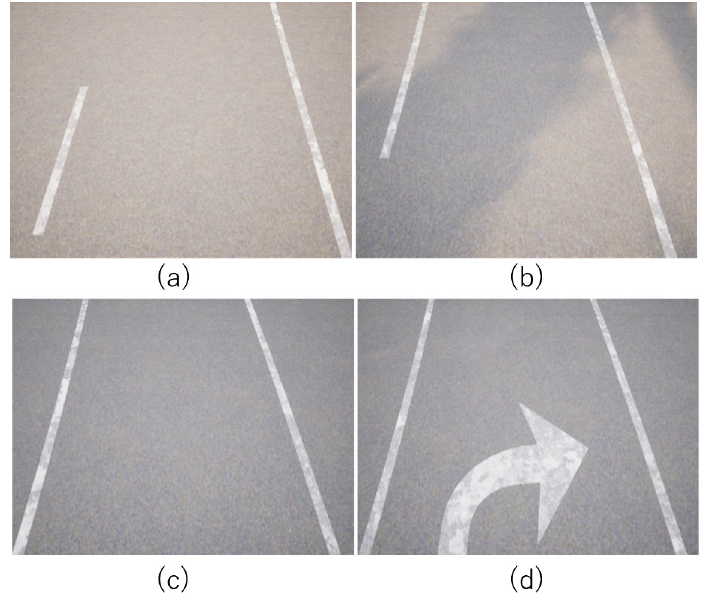
Figure 8. RGB images of scenes for the computational complexity experiments. ( a ) Scene 1. ( b ) Scene 2. ( c ) Scene 3. ( d ) Scene